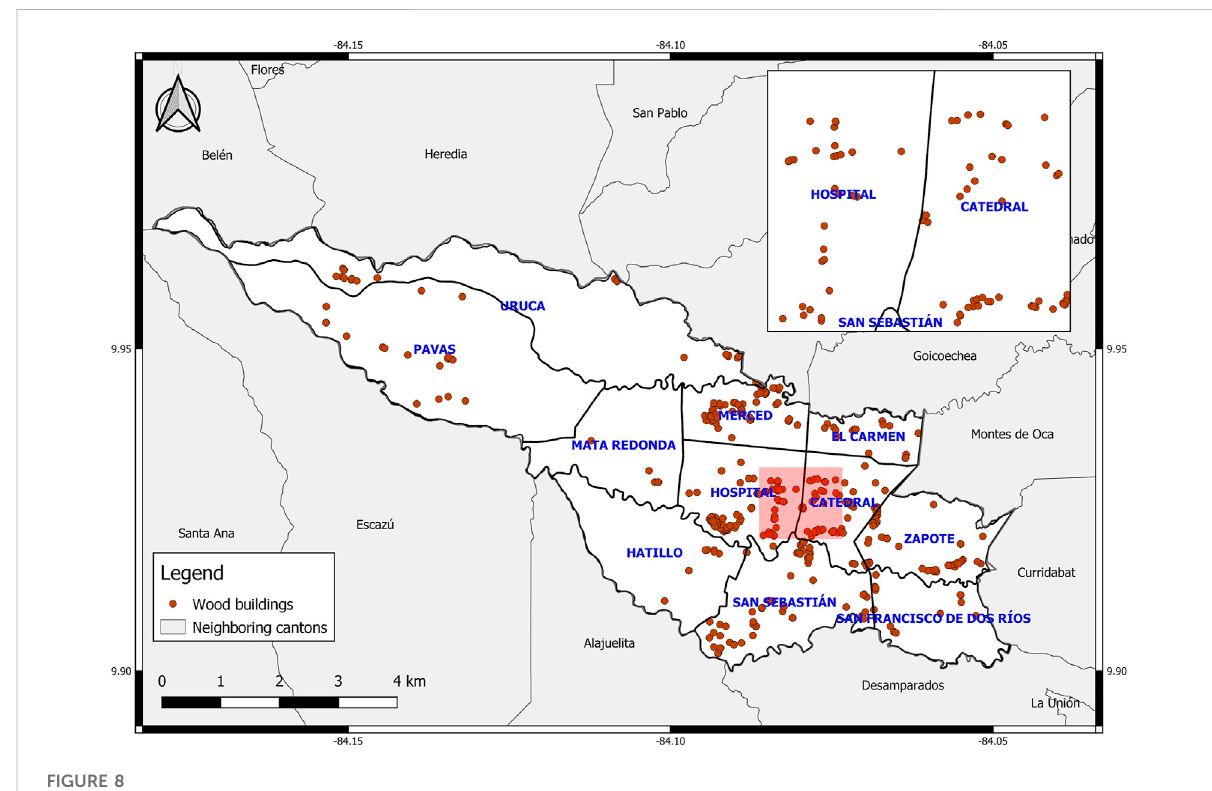
FIGURE 8 Map of buildings with wood material